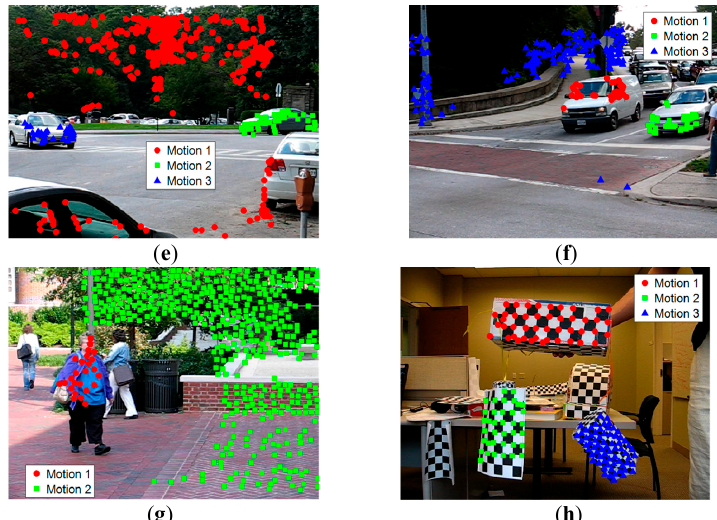
Figure 4. Sample results in video sequences of the Hopkins 155 dataset with the proposed method, with the different motions labeled with points of different colors and shapes. ( a ) 2RT3RCT_B, ( b ) 2RT3RTCRT, ( c ) 2T3RCR, ( d ) 2R3RTC, ( e ) cars5, ( f ) cars9, ( g ) people2, ( h ) articulated.